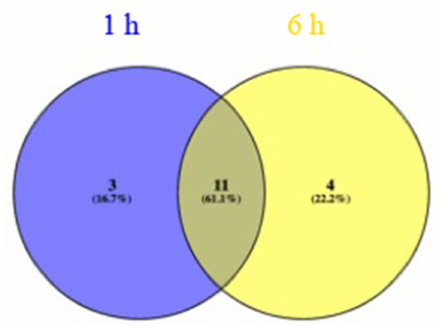
Figure 8. The overlap between transcription factor families significantly matched to the enriched motifs in the promoter regions of the di ff erentially expressed genes at T = 1 h and T = 6 h is